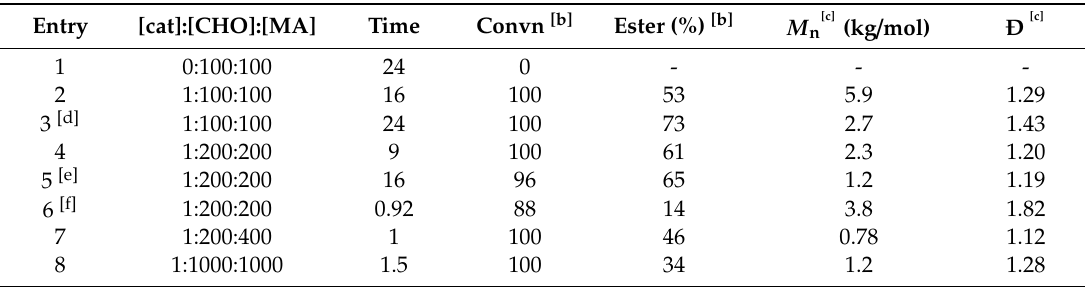
Table 1. Optimization of reaction conditions between maleic anhydride (MA) and cyclohexene oxide (CHO).